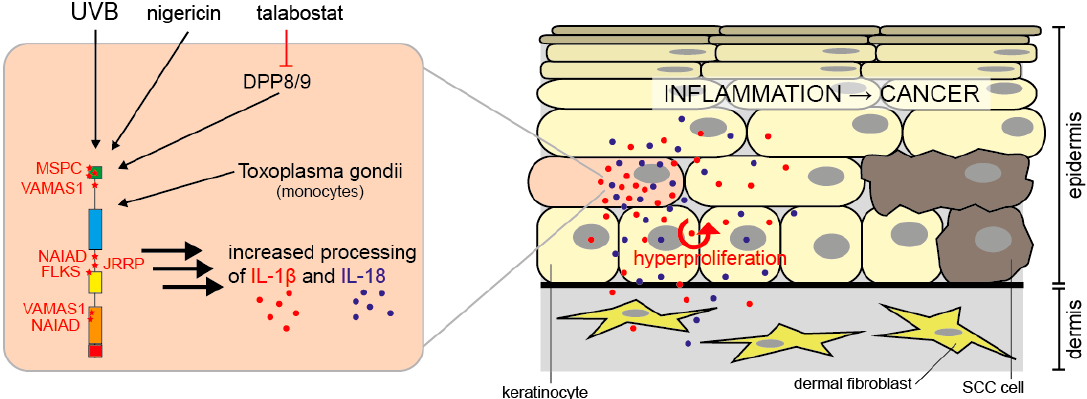
Figure 3. NLRP1 activation in human keratinocytes. In human keratinocytes, NLRP1 is activated by UVB radiation, nigericin, or talabostat. Toxoplasma gondii activates NLRP1 in